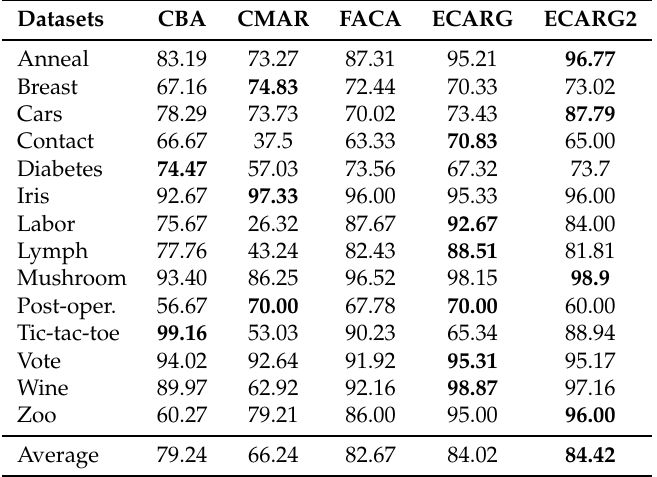
Table 10. Accuracies of CBA, CMAR, FACA, ECARG, and ECARG2.